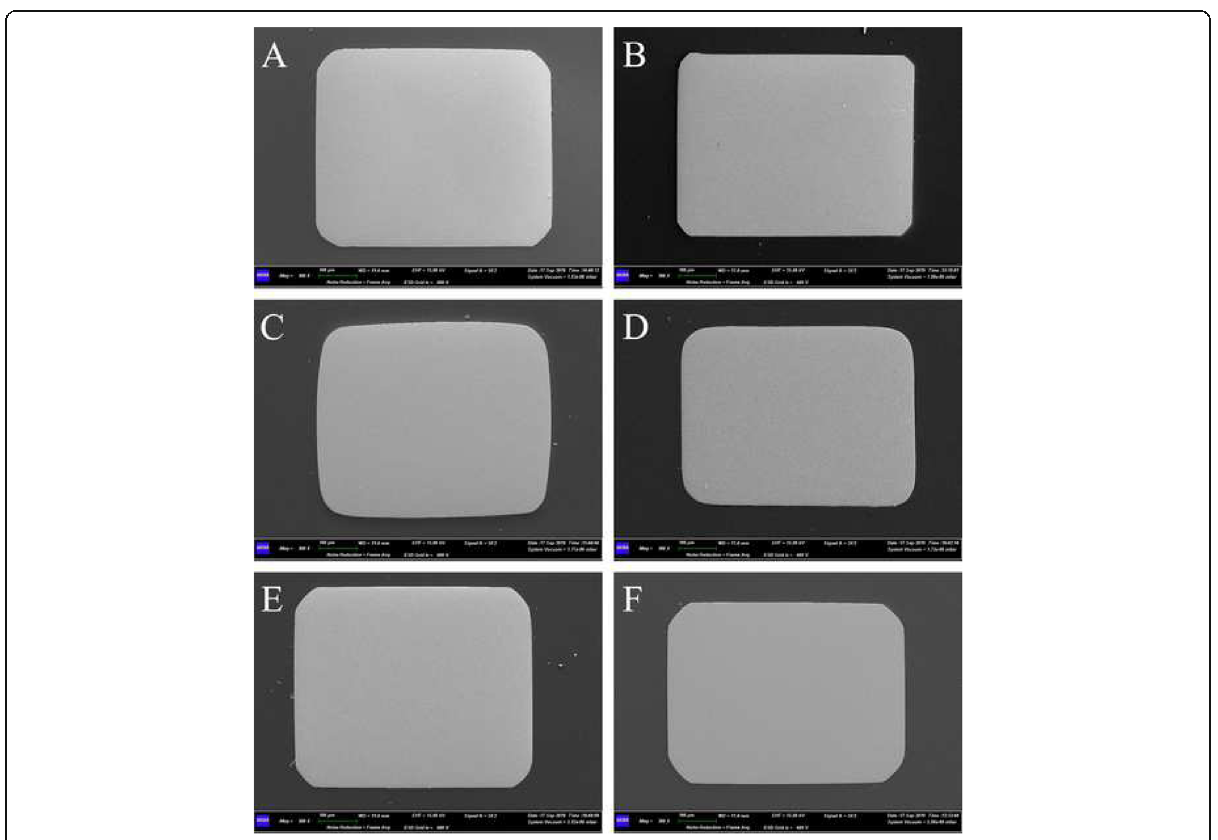
Fig. 5 Images of archwires ’ sections taken at 300× with a field emission gun scanning electron microscope under secondary electron modality. a 0.019 × 0.025 ″ stainless steel archwire from Group 1 (Astar Orthodontics Inc., Shanghai, China). b 0.021 × 0.025 ″ stainless steel archwire from Group 1. c 0.019 × 0.025 ″ stainless steel archwire from Group 2 (Sia Orthodontic Manufacturer S.r.l., Rocca D ’ Evandro, Caserta, Italy). d 0.021 × 0.025 ″ stainless steel archwire from Group 2. e 0.019 × 0.025 ″ stainless steel archwire from Group 3 (Sweden & Martina S.p.A, Due Carrare, Padova, Italy). f 0.021 × 0.025 ″ stainless steel archwire from Group 3